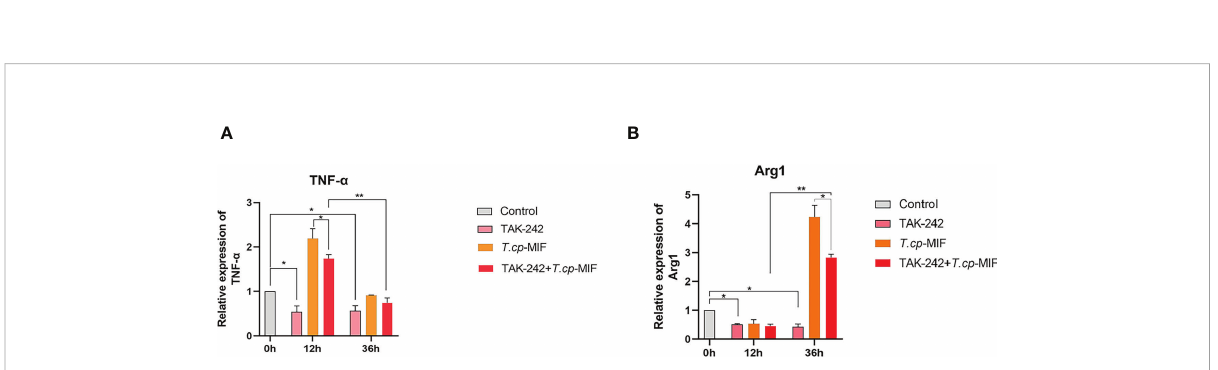
FIGURE 9 The effect of TAK-242 on the expression of TNF- a and Arg1. (A) the expression of TNF- a . (B) the expression of Arg1. * indicated P <0.05, ** indicated P <0.01. Results are showed as the mean of three times of independent experiments ( x ̄ ±SD,